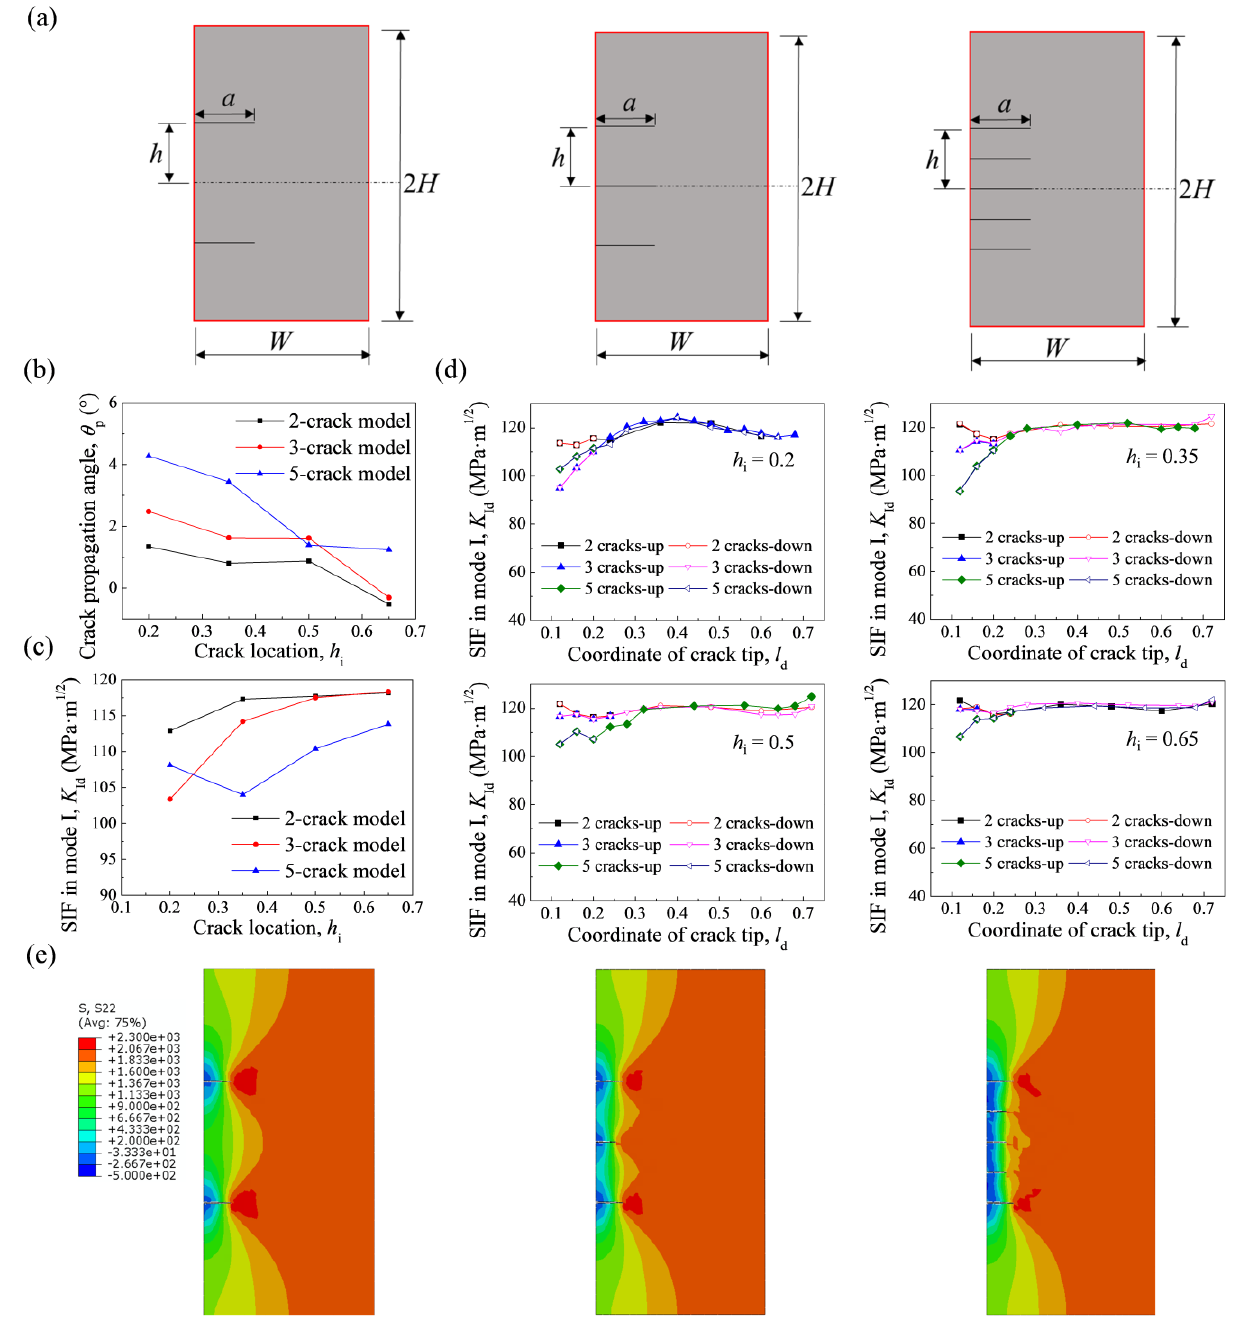
Figure 11. ( a ) Model with multi pre-cracks in an AerMet 100 plate 2-crack model, 3-crack model and 5-crack model; ( b ) Comparison of crack propagation angles in models with 2, 3 and 5 cracks; ( c ) Comparison of K Id in the crack propagation process and ( d ) K Id in the selected points when the initial crack number increase from 2 to 5 with the crack locations ranging from 0.2 to 0.65; ( e ) Comparison of stress contours when the crack with crack length 0.1 and crack location 0.35 propagates to 0.16 in 2-crack model, 3-crack model and 5-crack model.